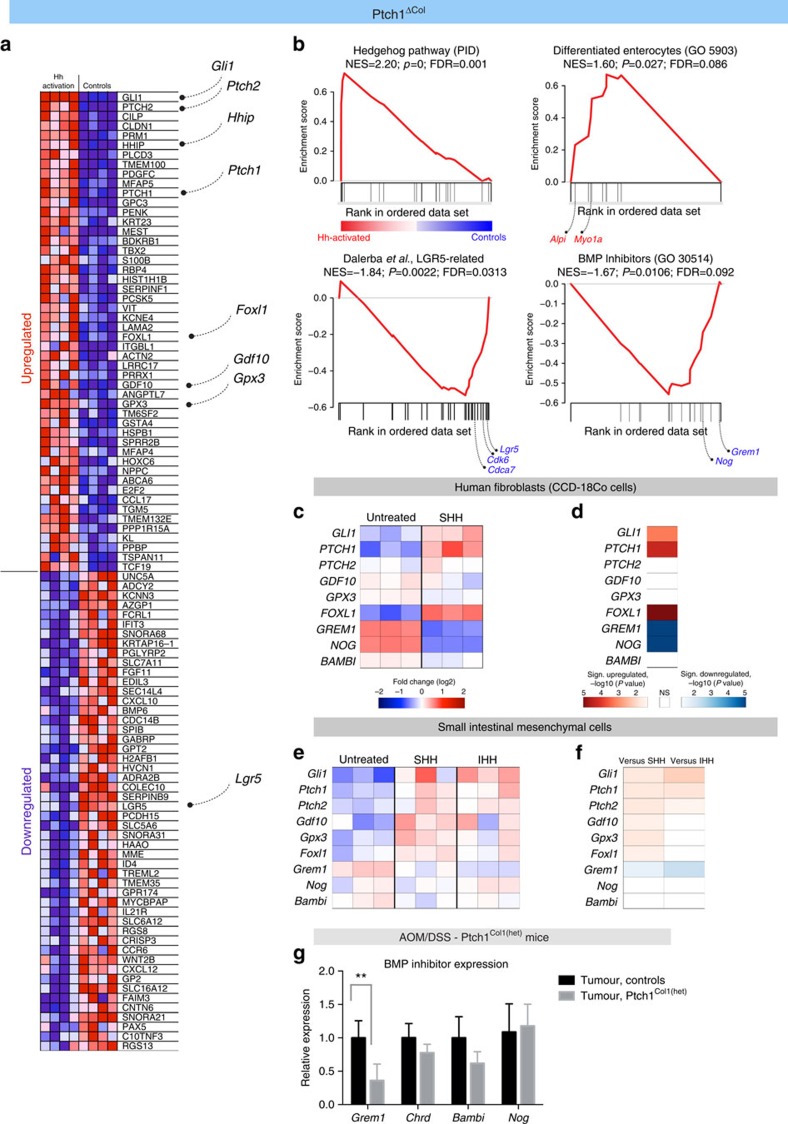
Transcriptional changes upon Hh activation.(a) Heatmap of the 50 highest ranked genes (using the GSEA algorithm58) in the murine colon upon knockout of stromal Ptch1 in Ptch1ΔCol1 mice (n=4) versus controls lacking Cre recombinase (n=4) 7 days after a single dose of 5 mg Tam i.p. (b) GSEA indicates activation of canonical Hh signalling (left upper panel); enrichment of genes associated with enterocyte differentiation (right upper panel, gene ontology (GO) term, GO:0005903) and downregulation of colonic stem cell-associated genes (left lower panel) in parallel with loss of secreted BMP inhibitors (right lower panel). Normalized enrichment score (NES), P-value and fdr are indicated in each panel; gene lists are presented in the Supplementary Material. (c) Gene expression of indicated transcripts in the human colon fibroblast cell line, CCd-18Co, treated with 1 μg ml−1 SHH or vehicle for 72 h (data derived from GEO29316 (ref. 33)). (d) Illustration of significant changes in gene expression (fdr adjusted); note highly significant downregulation of GREM1 and NOG, and upregulation of FOXL1. (e) Gene expression in cultured intestinal mesenchyme from E18.5 mouse embryos treated with Ihh or Shh amino-terminal polypeptide (2.5 μg ml−1) or vehicle for 24 h (data derived from GEO17840); scale as in c. (f) Illustration of significant changes in gene expression (fdr adjusted); Grem1 was downregulated by both Shh and Ihh treatment; upregulation of Gdf10, Gpx3 and Foxl1 was significant in Shh-treated mesenchyme. Scale as in d. (g) mRNA expression of the indicated transcripts in tumours of Ptch1Col1(het) mice (n>5) and tumours from control mice (lacking Cre recombinase, floxed Ptch1 alleles or both; n>8); P-values from t-tests with fdr correction indicated, P=0.001 (Grem1), P=0.558 (Nog), P=0.603 (Chrd), P=0.206 (Bambi) and **P<0.01.